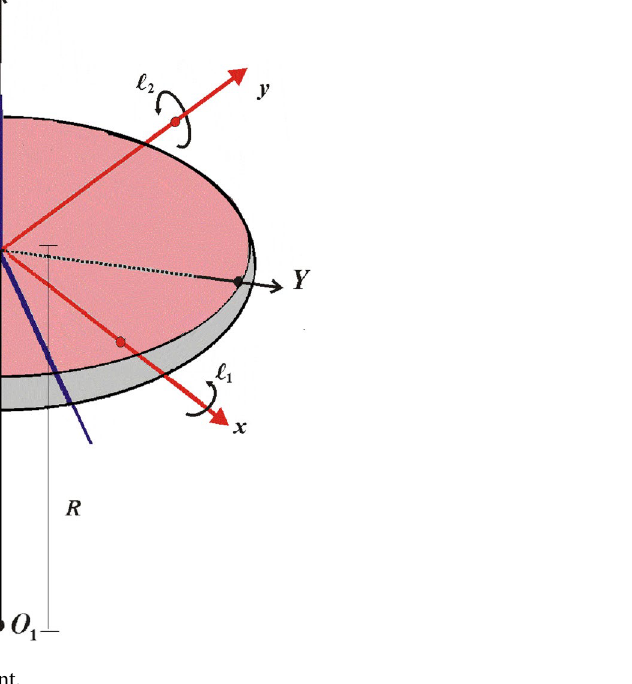
Figure 1. The force